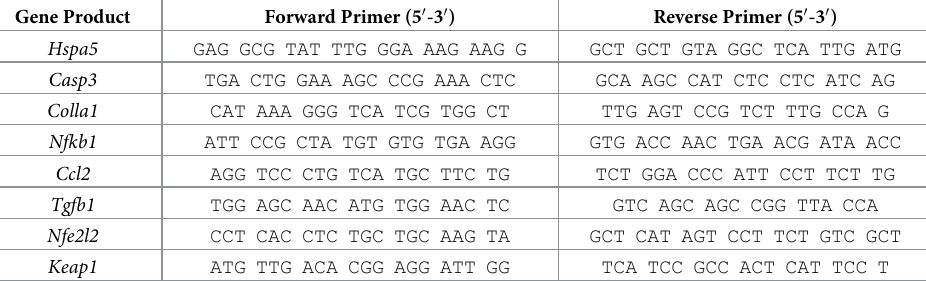
Table 1. List of primers used for